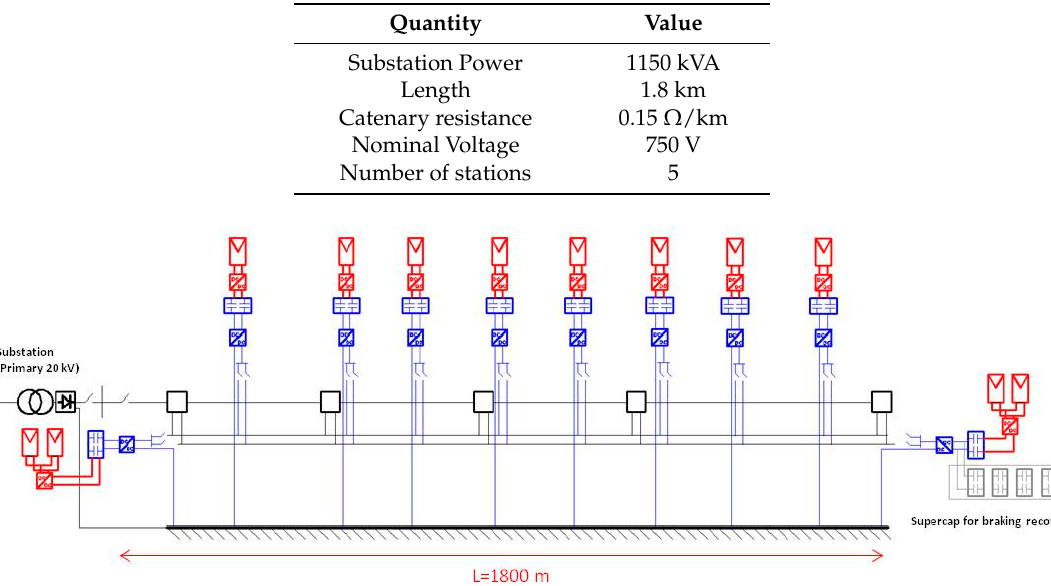
Figure 4. Model of the electric scheme shown in Figure 6.